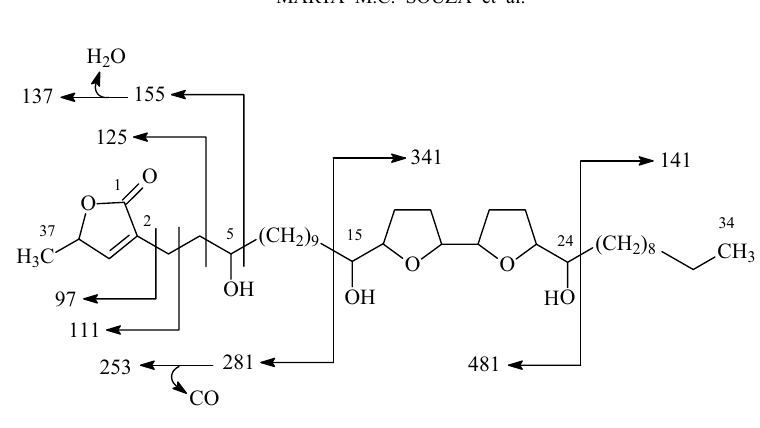
Fig. 1 – Mass spectral fragmentation of 1